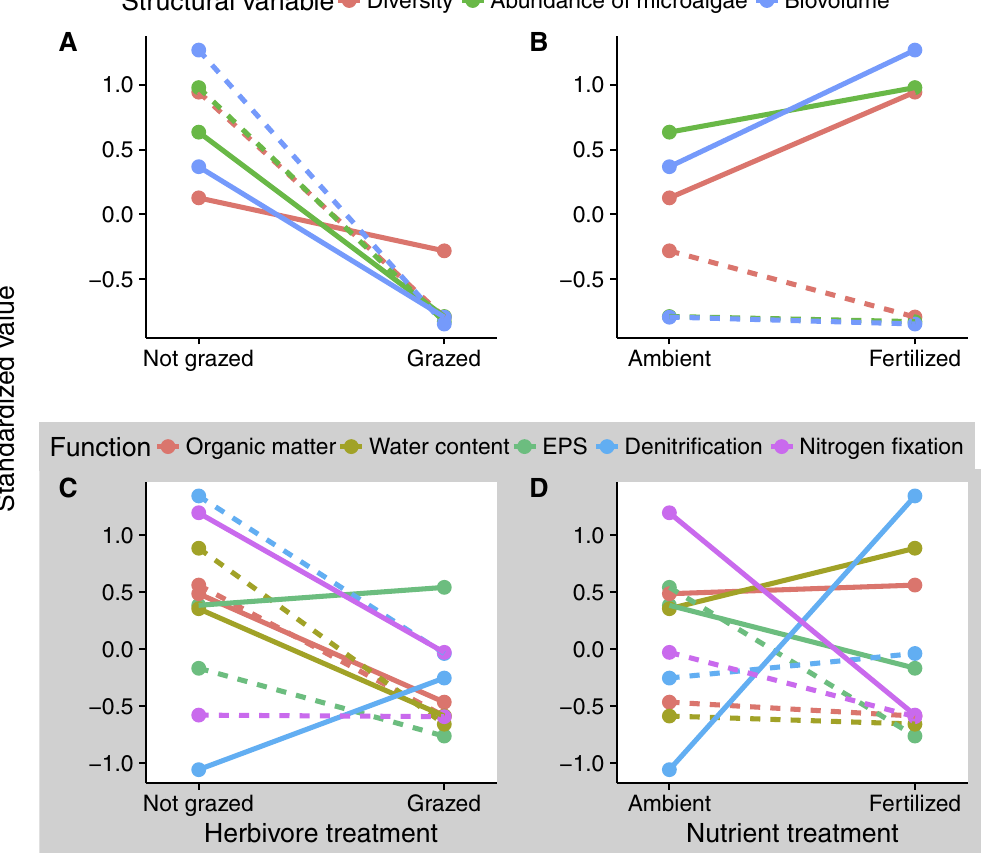
Figure 2. Effect of increased nutrients and altered consumer populations on the standardized diversity, abundance and biomass of benthic microalgae ( A , B ) and five standardized ecosystem functions ( C , D ). Each color represents the mean response to the